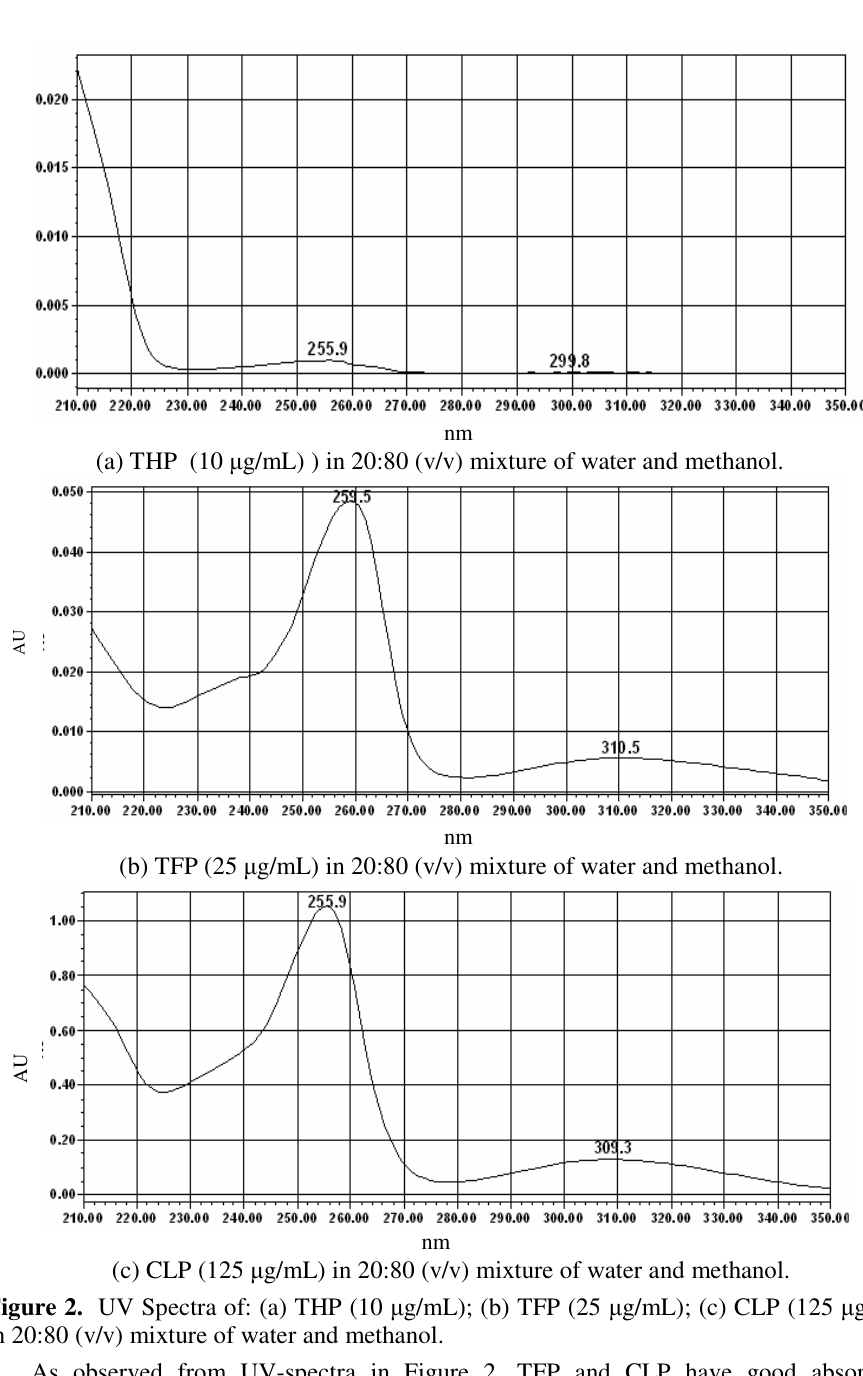
Figure 2. UV Spectra of: (a) THP (10 µ g/mL); (b) TFP (25 µ g/mL); (c) CLP (125 µ g/mL) in 20:80 (v/v) mixture of water and